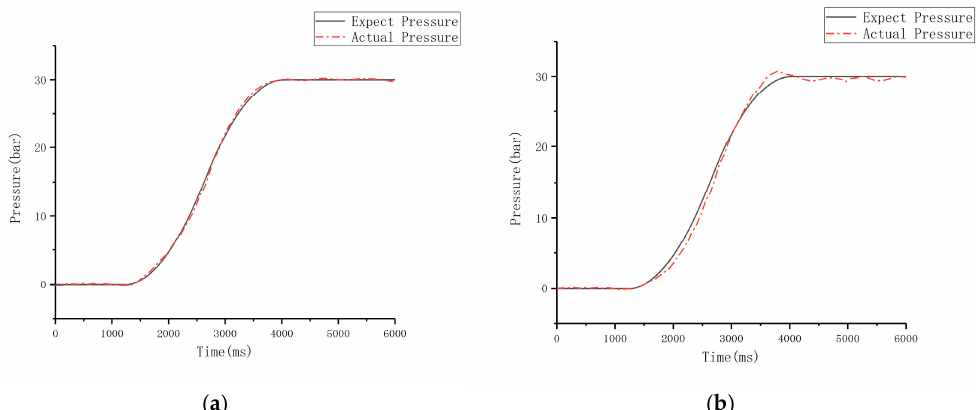
Figure 15. Step signal pressure simulation curve. ( a ) Pressure curve of DTC system controlled by sliding-mode system under step signal. ( b ) Pressure curve of variable-speed system under step signal.